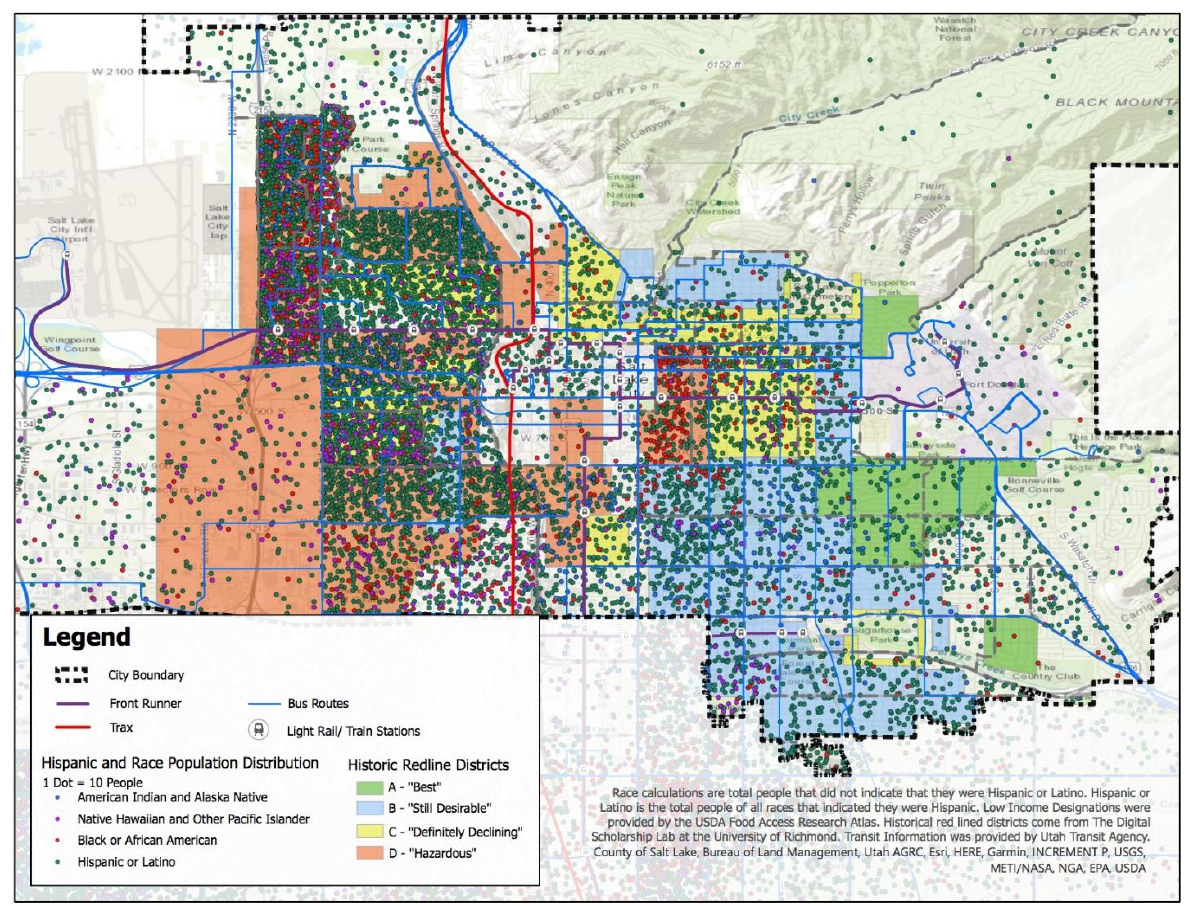
Figure 4. Hispanic and Racialized Population Distributions and